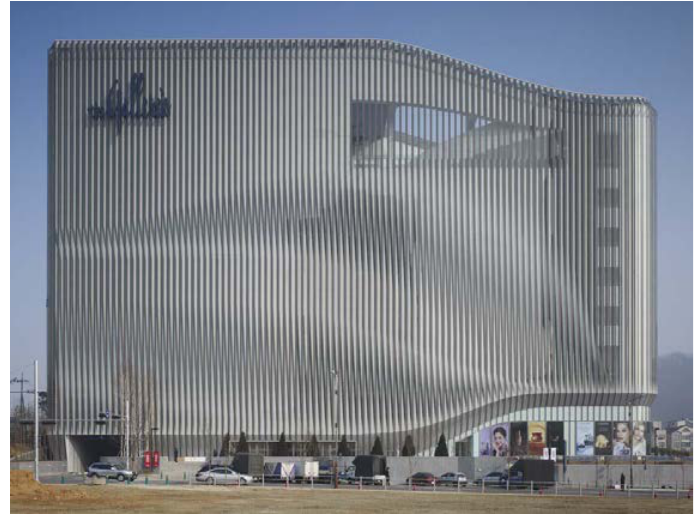
Fig. 6 Daytime view of the Galleria Centercity. © Kim